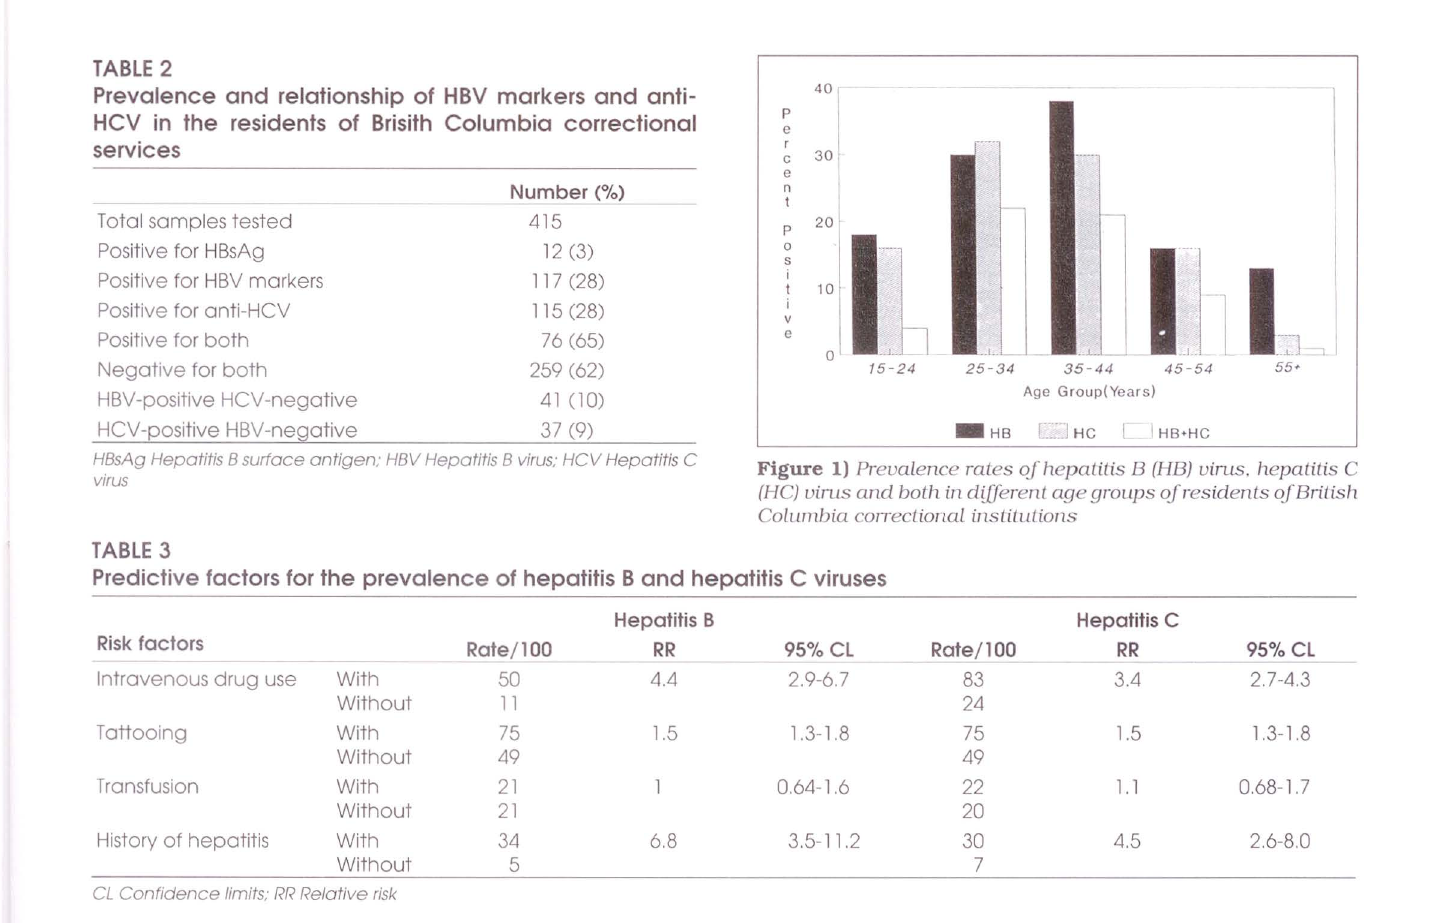
Figure 1) Prevalence rates of hepatitis B (HB) uirllS. hepatitis C (HC) virus and both in different age groups of residents of British Columbia corTeclional insututions